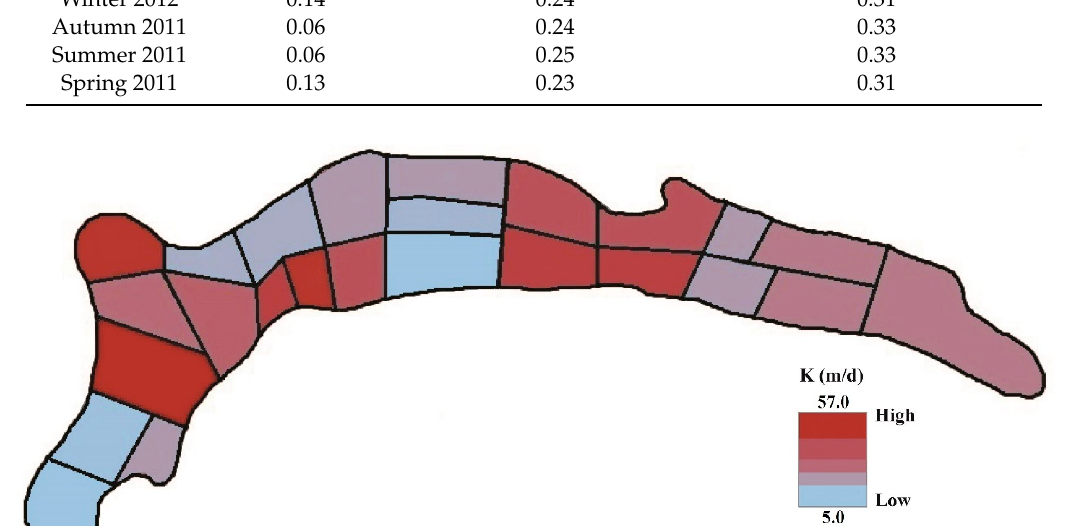
Figure 15. Distribution of hydraulic conductivity values in Birjand aquifer.